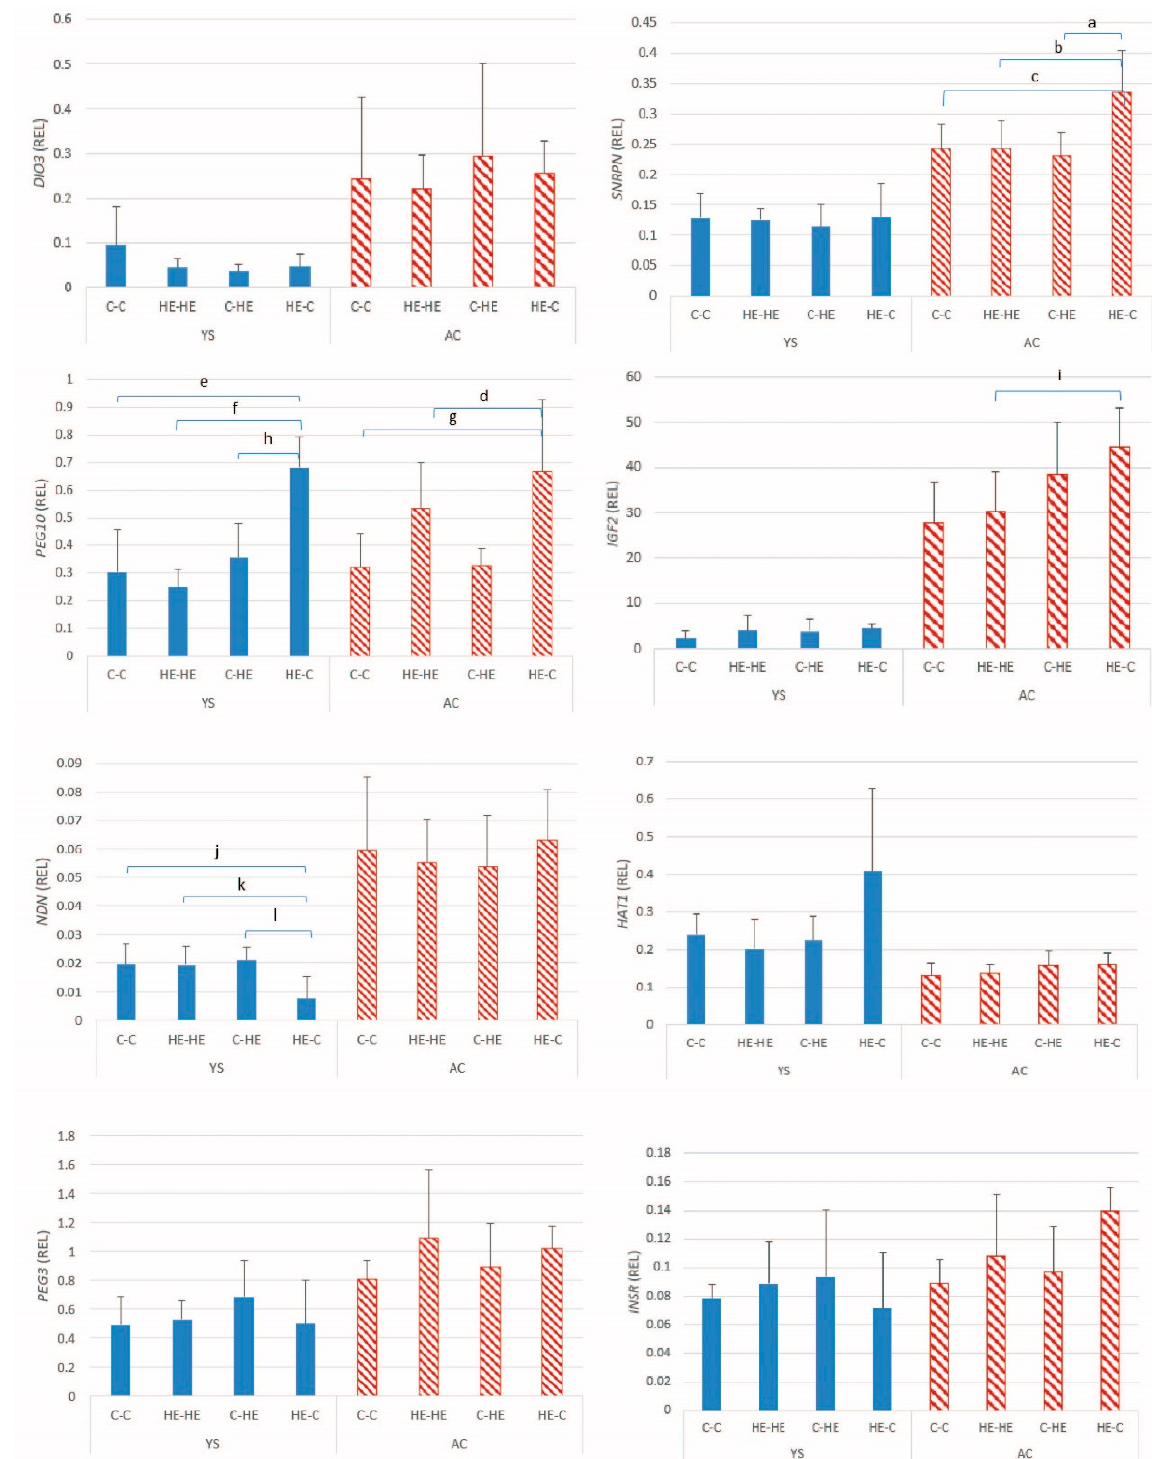
Figure 5. Mean ± SD relative gene expression (REL) for the paternally expressed genes in the yolk-sac (YS) and allantochorionic (AC) membranes at day 28 of conceptus development, after transfer of day-7 embryos from a control to a control Shetland pony mare (C-C; n = 4), high-energy (HE) to HE mare (HE-HE; n = 4), control to HE mare (C-HE; n = 4) or HE to control mare (HE-C; n = 4). a P = 0.01; b P = 0.011; c P = 0.026; d P = 0.035; e P = 0.002; f P = 0.001; g P = 0.018; h P = 0.008; i P = 0.047; j P = 0.041; k P = 0.024; l P = 0.041. Table 5. P values for the difference (main group effect) in expression for selected genes in allanto- chorion and yolk-sac membranes and endometrial tissue recovered from Shetland pony mares on day 28 of gestation following transfer of embryos between overfed and control mares on day 7 after ovulation. p values < 0.05 are indicated by a * . Gene